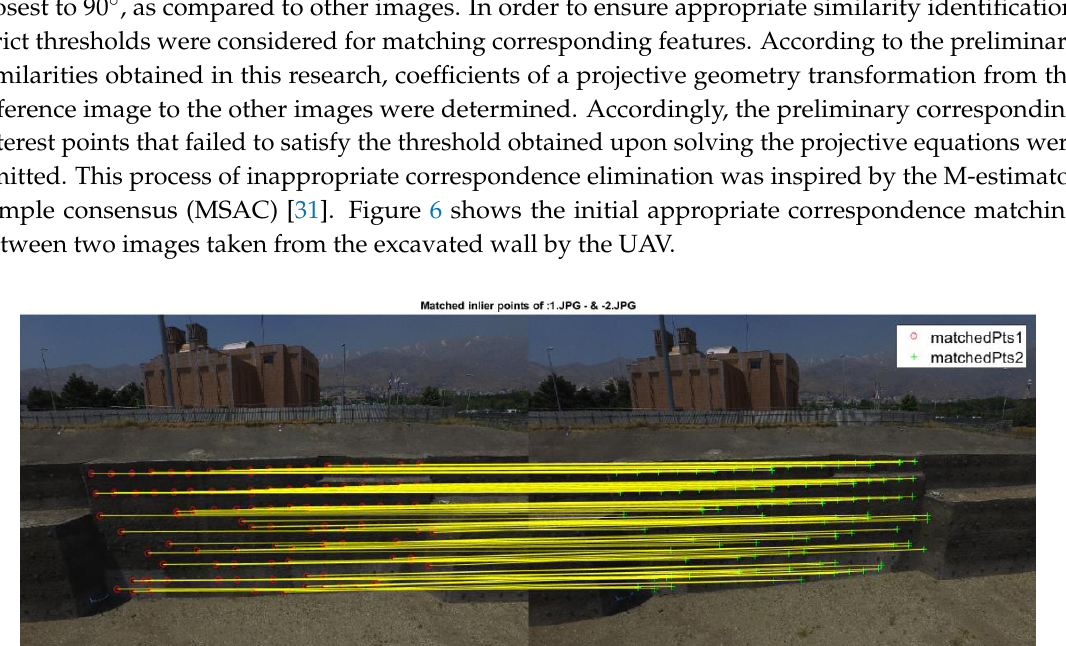
Figure 6. An example of initial correspondence matching between two images, with false correspondences omitted.